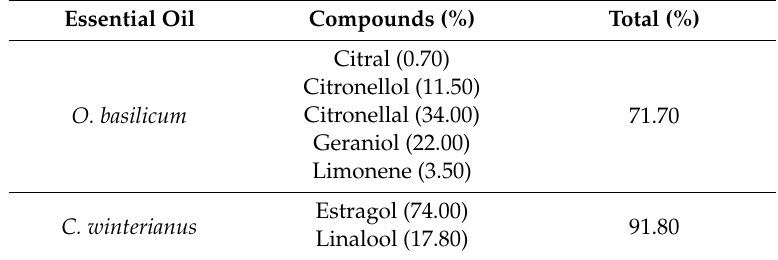
Table 1. Composition of basil and citronella essentials oils obtained with gas chromatographic